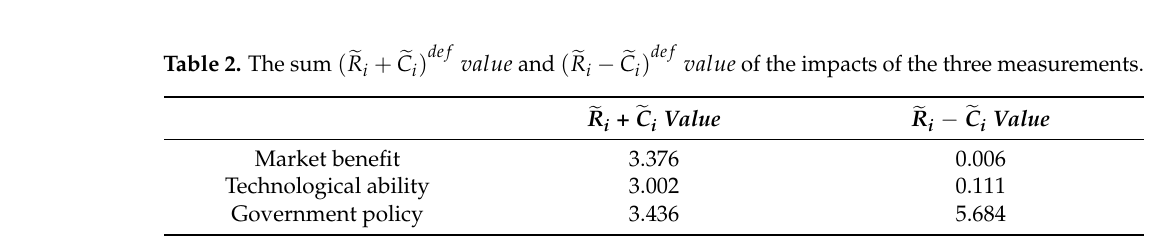
Table 2. The sum ( (cid:101) R i + (cid:101) C i )